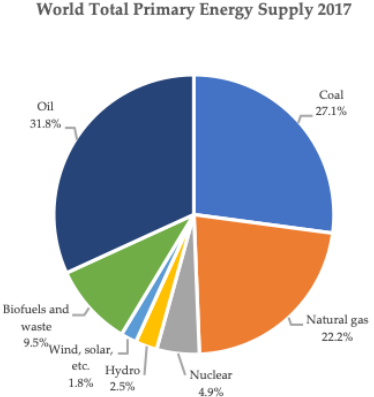
Figure 1. World Total Primary Energy Supply 2017 (Source: IEA).